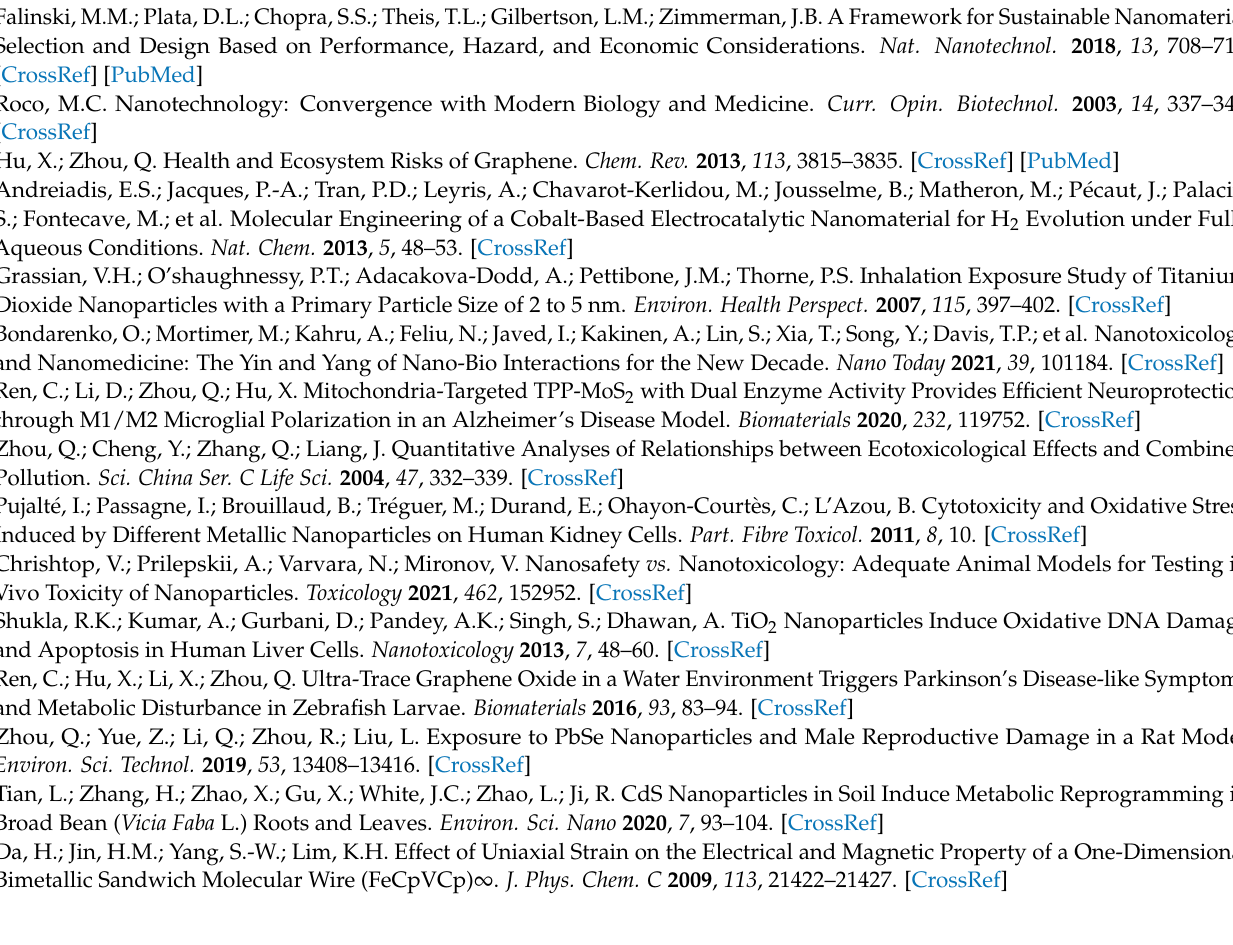
experiment. Figure S2. Characterization of the synthesized CdSe nanorods. (a) TEM observation; and (b) powder XRD analysis. Table S1. The particle size, hydrodynamic diameter (DLS) and zeta potential of the synthesized CdSe